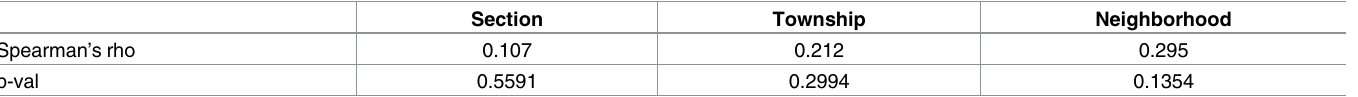
Table 4. Spearman correlation between delay to recurrenceand number of wolves killed after depredation events followed by lethal intervention (wolves killed (cid:21) 0), for all spatial